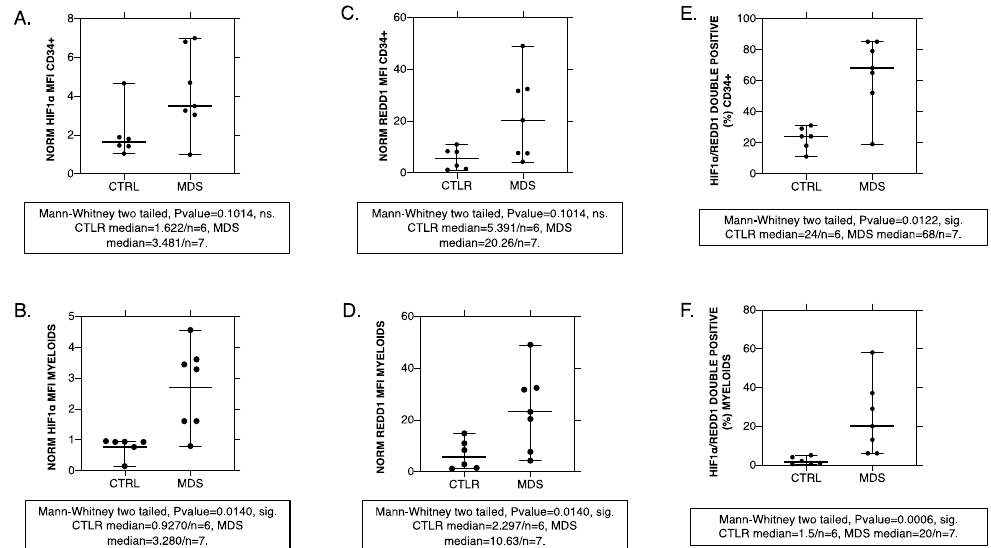
Figure 1. Hypoxia-inducible factor 1 (HIF-1 α ) and regulated in development and DNA damage response 1 (REDD1) protein kinetics in CD34+ and differentiating myeloid lineage from controls (CTRL, n = 6) and myelodysplastic syndromes (MDS, n = 7) patients. HIF-1 α ( A , B ), REDD1 ( C , D ) expression as well as HIF-1 α /REDD1 co-expression ( E , F ) were assessed through flow cytometry with subsequent statistical analysis to yield significance. Although great variability exists in the MDS group owing to and reflecting upon the syndromic nature of this clinical entity, a difference does exist between CTRLs and MDS even if significance fails to be established ( A , B ). No correlation was established with MDS severity; thus, all samples, namely both from <5% and ≥ 5% intra BM blast counts were assessed together. However, we do underline that peak HIF-1 α and REDD1 median fluorescence intensity (MFI) values in myeloids, the differentiation stage at which HIF-1 α levels and thus MFI ought to be physiologically declining, correspond to low-risk patients ( B , D ). In the CD34+ group, such a correlation was not observed ( A , C ). The phenomenon is also reflected upon the pattern of HIF-1 α /REDD1 coexpression ( E , F ) where peak coexpression also corresponds to the same low-risk patients. The great variability in coexpression in the MDS group suggests a more complex nature of REDD1 upstream regulation aside form HIF-1 stability that is observed not only in the myeloid group ( F ) but also in the CD34+ HSCs ( E ). ns: non-significant, sig.: significant. Mann–Whitney p -value > 0.05 or <0.05